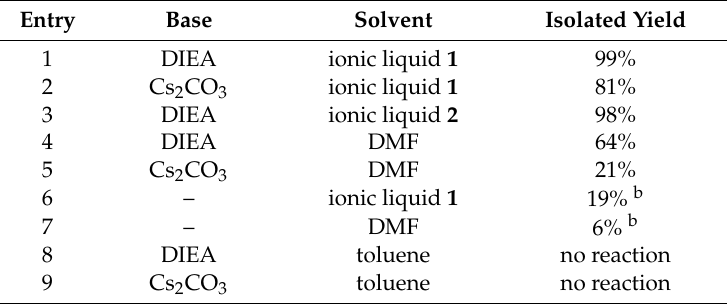
Table 1. Synthesis of tryptanthrin in ionic ( 1 , 2 ) and molecular (DMF, toluene) solvents a .